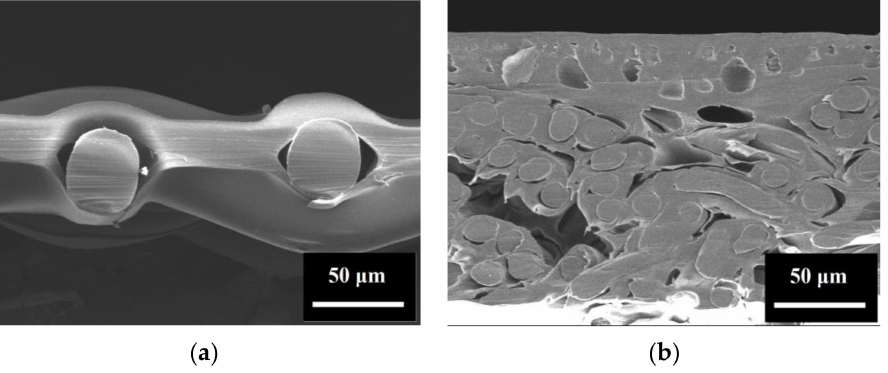
Figure A1. FESEM micrographs of the cross-sections (at 500 × ) of ( a ) CTA-W and ( b ) CTA-NW.